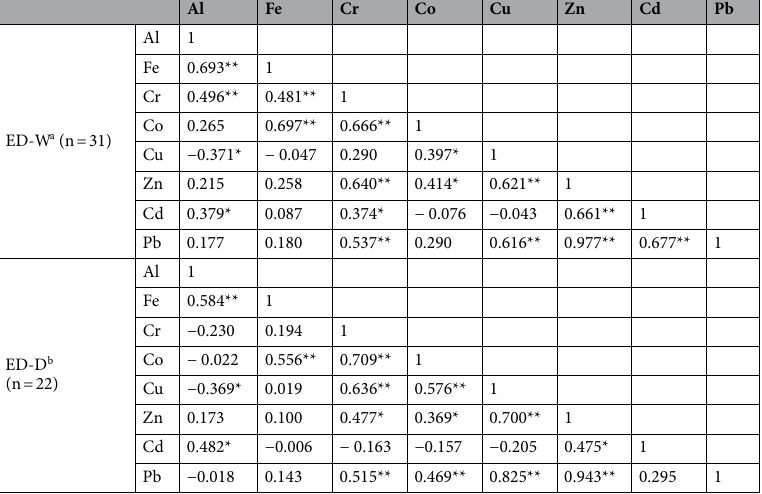
Table 4. Pearson correlation coefficients between concentrations of eight elements in sediments from the East Dongting Lake in the wet and dry seasons. a East Dongting Lake in the wet season. b East Dongting Lake in the dry season. *Correlation is significant at the 0.05 level (2-tailed). **Correlation is significant at the 0.01 level (2-tailed).